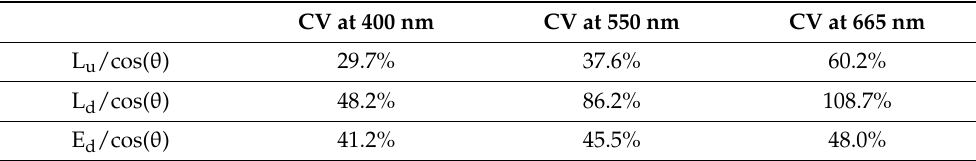
Table 1. Coefficient of variation for cosine-normalized radiometric measurements at selected wave- lengths for the 18-day